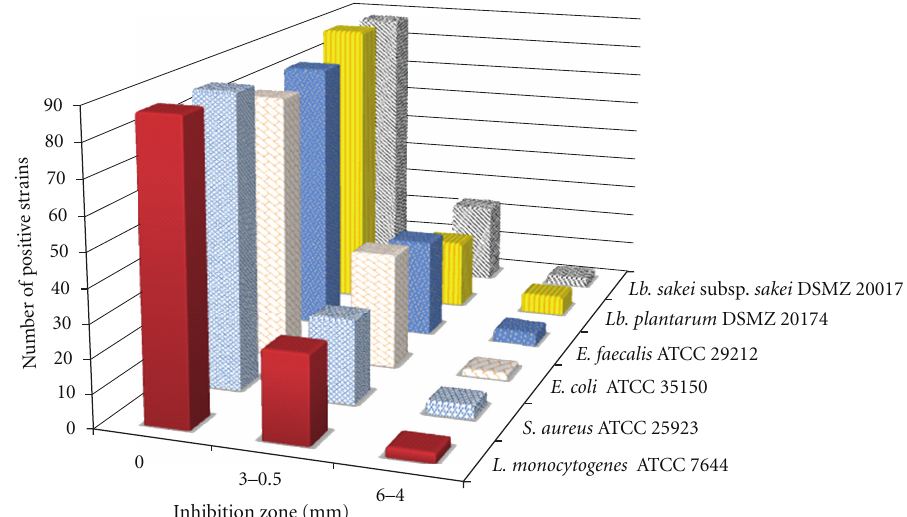
Figure 1: Preliminary screening for antibacterial activity of Lactococcus lactis subsp . lactis strains isolated from artisanal dairy products. Table 2: Enzyme sensitivity of the antibacterial compounds produced by the six Lactococcus lactis subsp. lactis determined by well-di ff usion assay. Results are expressed as mean ± standard deviation of three independent experiments. Residual activity against L. monocytogenes ATCC 7644 after enzymes treatment ∗ Producer strains Control Pronase E Proteinase K a-Chymotrypsin Trypsin Papain 9FS16